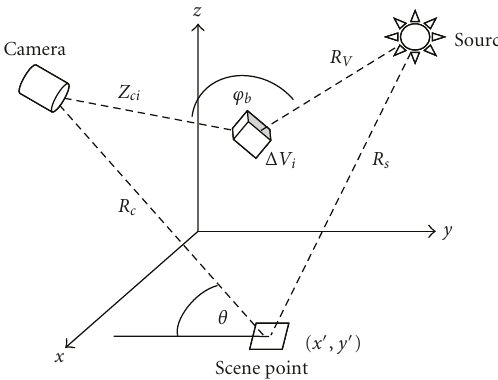
Figure 2: Coordinate system of the Ja ff e-McGlamery